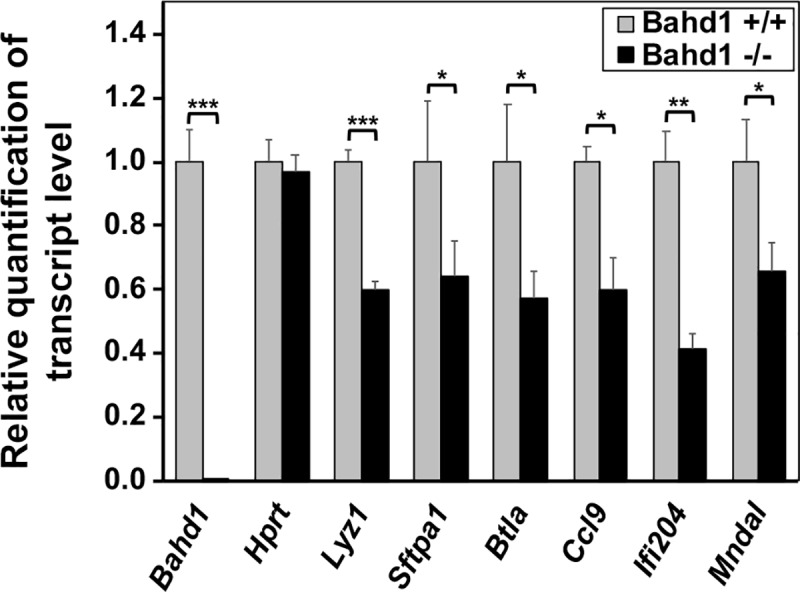
A set of immunity-related genes is downregulated in Bahd1−/− brains in comparison with Bahd1+/+ brains.Relative transcript levels of immunity-related genes in Bahd1−/− brains relative to that in Bahd1+/+ brains (n = 3 for each genotype), as determined by RT-qPCR (mean ± S.E.M.; * p<0.05, ** p<0.01, *** p<0.001).